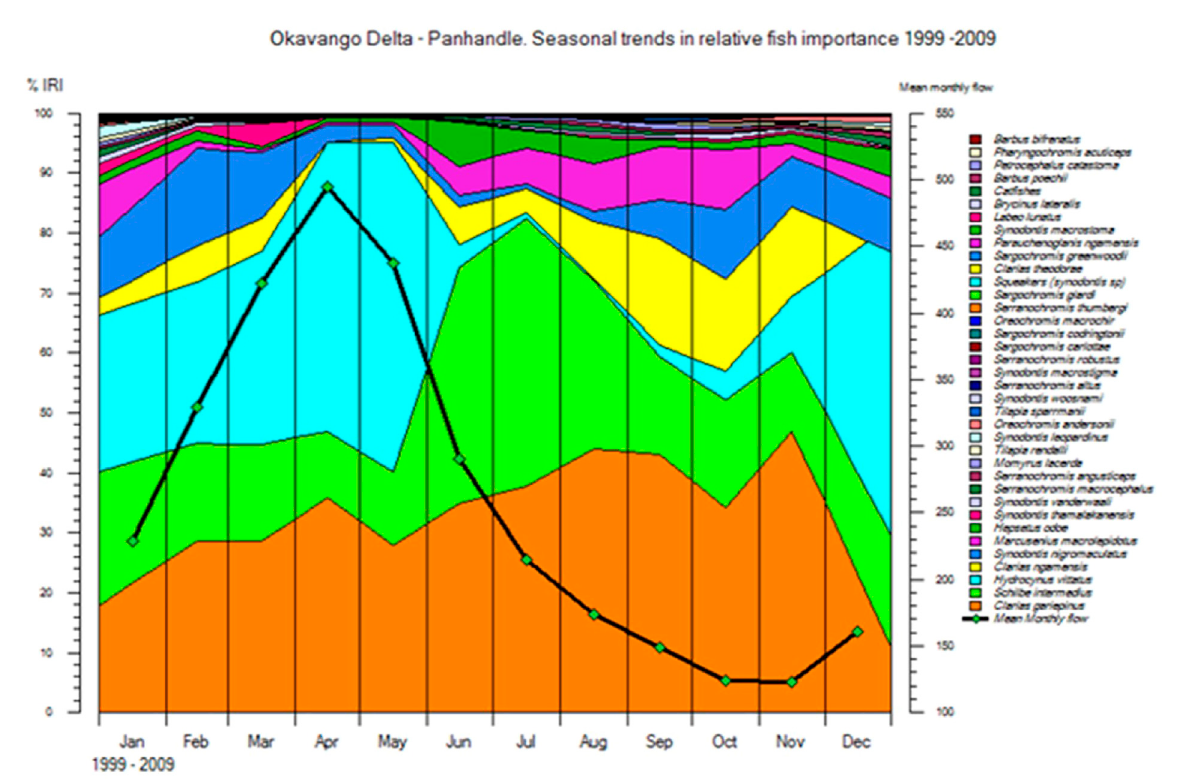
FIGURE 2 Intra annual variations in fi sh species biodiversity in the Okavango Delta where the black line shows seasonal variability in mean discharge (Source: Mosepele et al.,